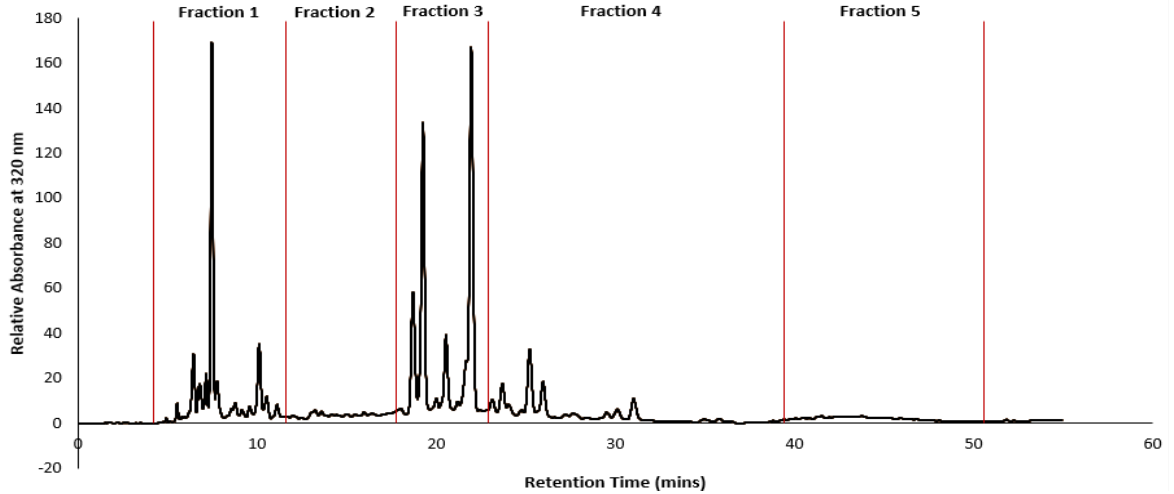
Figure 9. HPLC chromatogram of P. angustifolium and retention times at which fractions were col- lected.